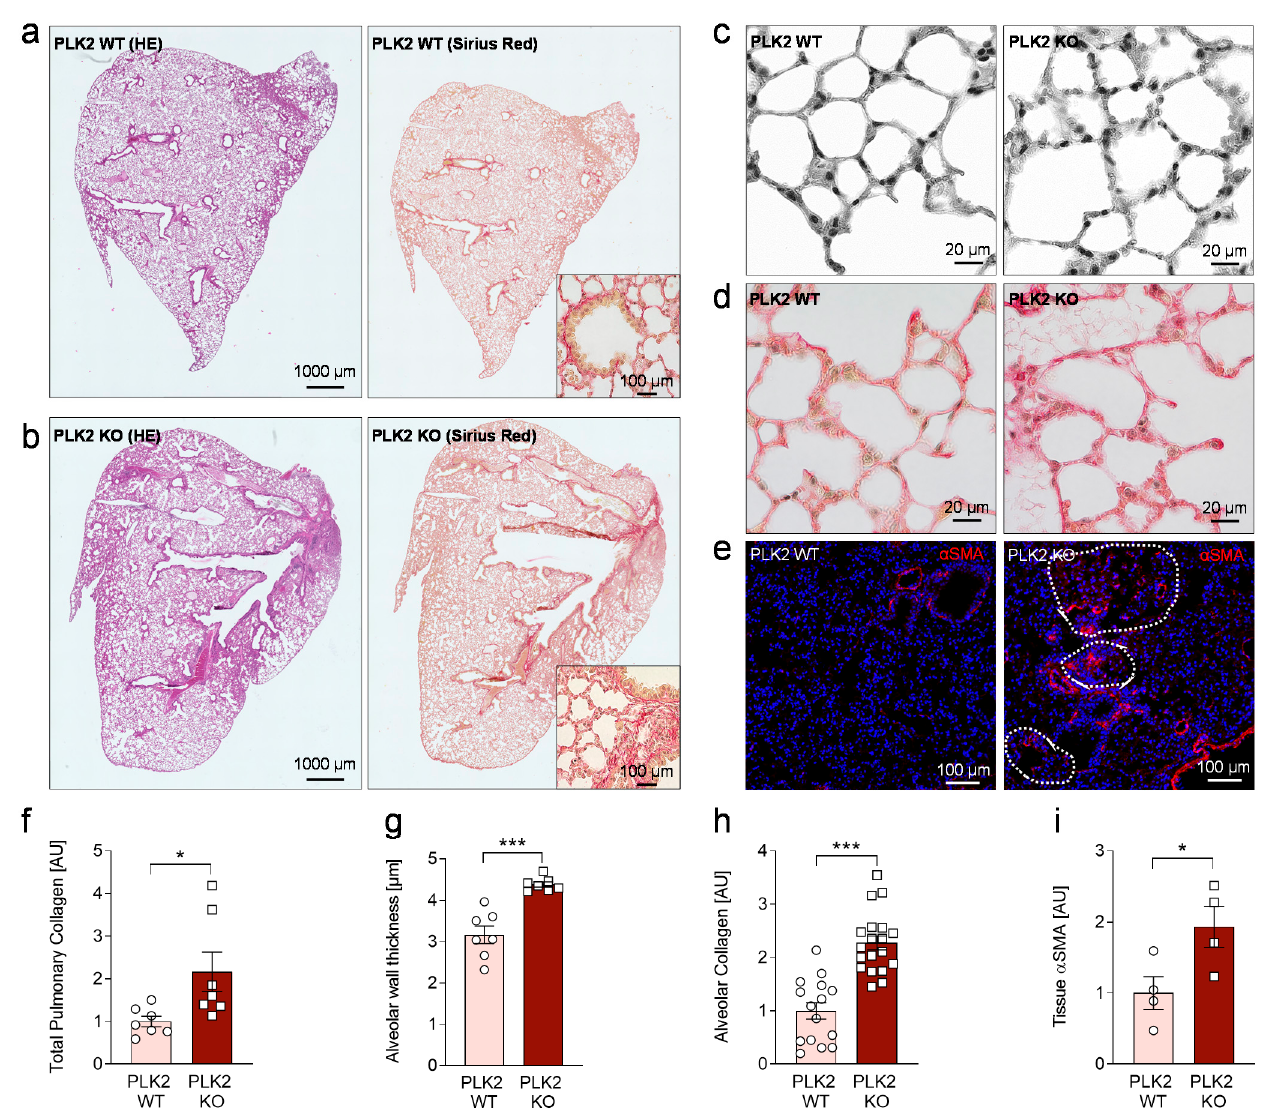
Figure 3. Histological analysis of PLK2 WT and KO lung sections. ( a , b ) Representative images of hematoxylin/ eosin and picrosirius red collagen staining in PLK2 WT and KO lung sections. The scale bars equal 1000 and 100 µ m for the inlets, respectively. ( c ) Representative images of PLK2 WT and KO alveolar tissue (black and white for better contrast visualization). The scale bars equal 20 µ m. ( d ) Representative picrosirius red images of PLK2 WT and KO alveolar collagen. The scale bars equal 20 µ m. ( e ) Representative immunofluorescence images of α SMA (red) and nuclei (blue) in PLK2 WT and KO lung sections. Highlighted areas (dashed white outline) show myofibroblast accumulation (foci). The scale bars equal 100 µ m. ( f ) Quantification of total pulmonary collagen content in PLK2 WT and KO lung sections ( n WT = 7, n KO = 7). ( g ) Quantification of alveolar wall thickness [ µ m] ( n WT = 7, n KO = 7). ( h ) Quantification of alveolar collagen in PLK2 WT and KO lung sections ( n WT = 15 analyzed imaged from 5 animals, n KO = 19 analyzed images from 6 animals). ( i ) Quantification of α SMA fluorescence intensity (normalized to nuclei) in PLK2 WT and KO lung sections ( n WT = 4, n KO = 4). * p < 0.05. *** p < 0.001.